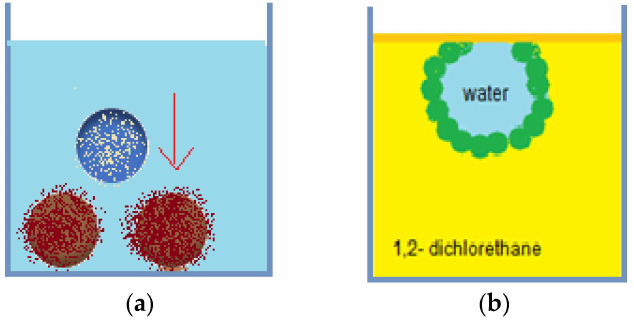
Figure 16. ( a ) Lycopodium covered liquid marbles submerged in PDMS; ( b ) Liquid marbles anchored at air/1,2-dichlorethane